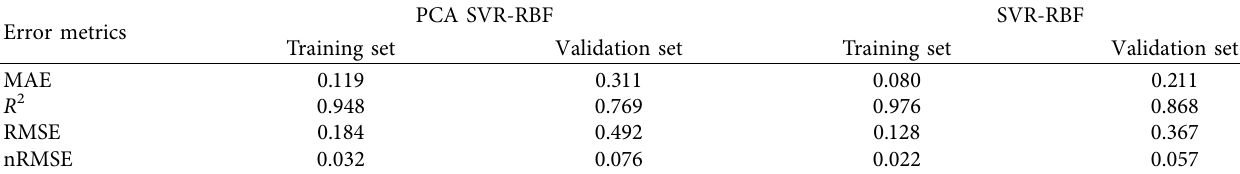
Table 6: Error metrics from CO forecasting models in the training and validation sets.